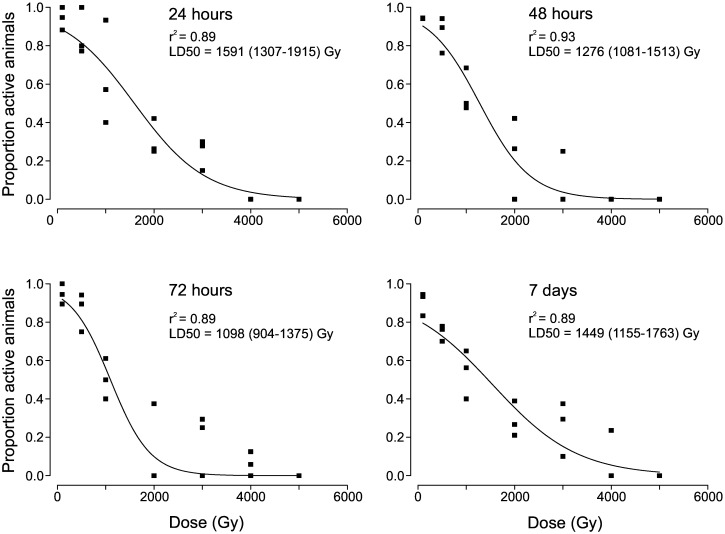
Dose-response curves showing the proportion of active Echiniscoides sigismundi after different doses of gamma radiation, at activity assessments 24h, 48h, 72h and 7 days after irradiation.Data for non-irradiated samples were excluded. Each data point shows the proportion of active tardigrades out of approx. 20 animals. LD50 values (with 95% confidence intervals in parentheses) obtained from dose-response fitting and the statistical support of the regressions are given within each graph.